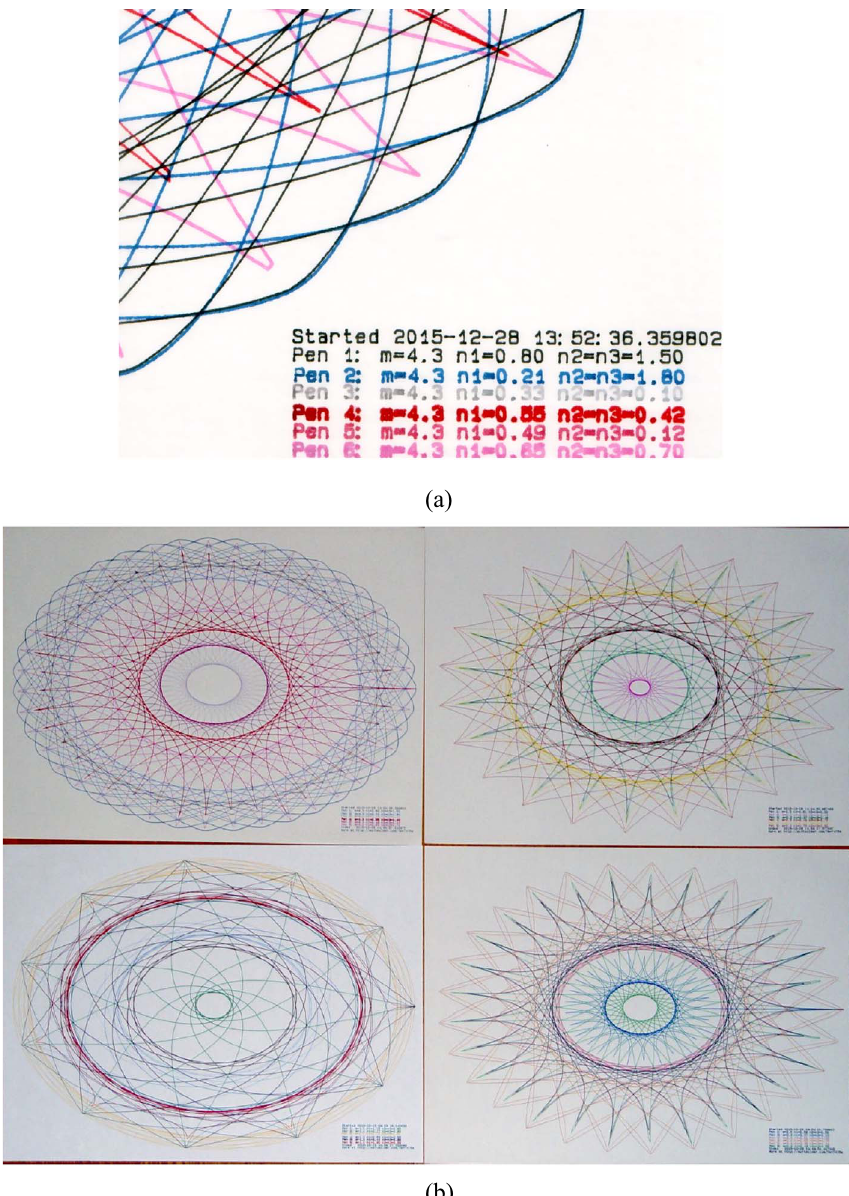
Figure 20. Gielis curves created with an HP7475A plotter [19]. (a) Details for a polygon with m = 43/10 with different colours for different exponents. (b) The complete